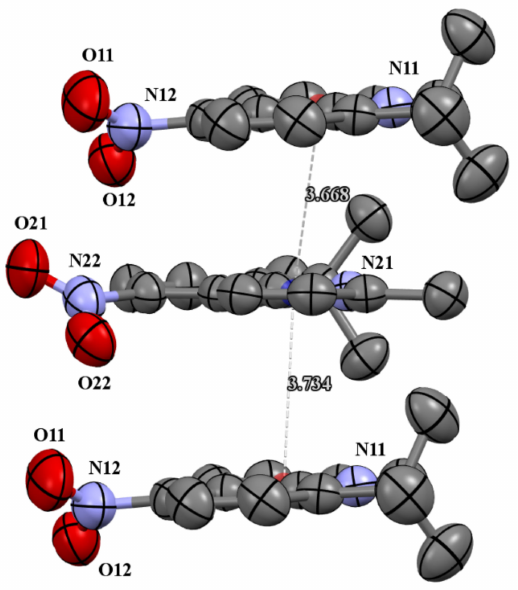
Figure 3. The π -stacking interactions in cell packing of compound 4c